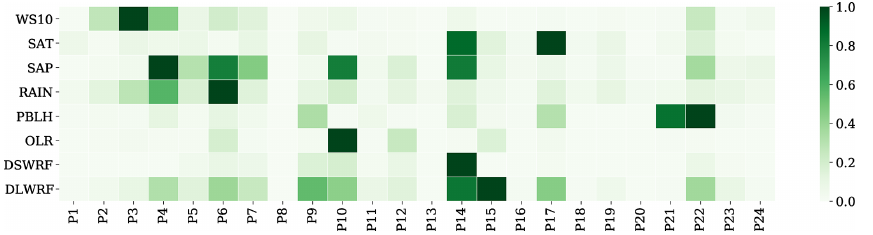
Figure 3. The heatmap of the normalized MOAT-modified means of 24 parameters for the meteorological variables considered, with one implying the most sensitive parameter and zero implying the least sensitive.